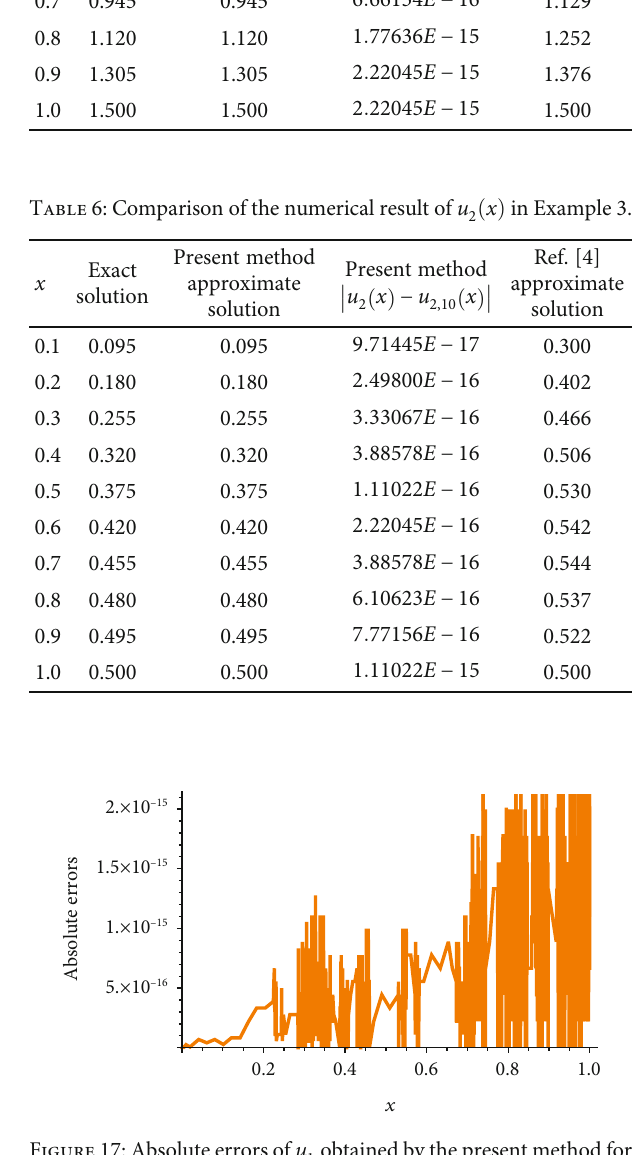
Figure 14: Comparisons between numerical and exact solutions of u 2 obtained by the present method for Example 2.